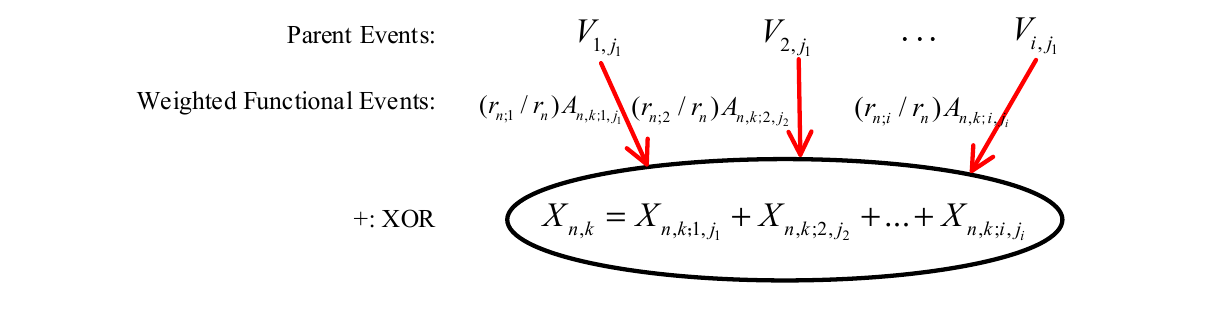
Figure 3. Illustration of the DUCG model.